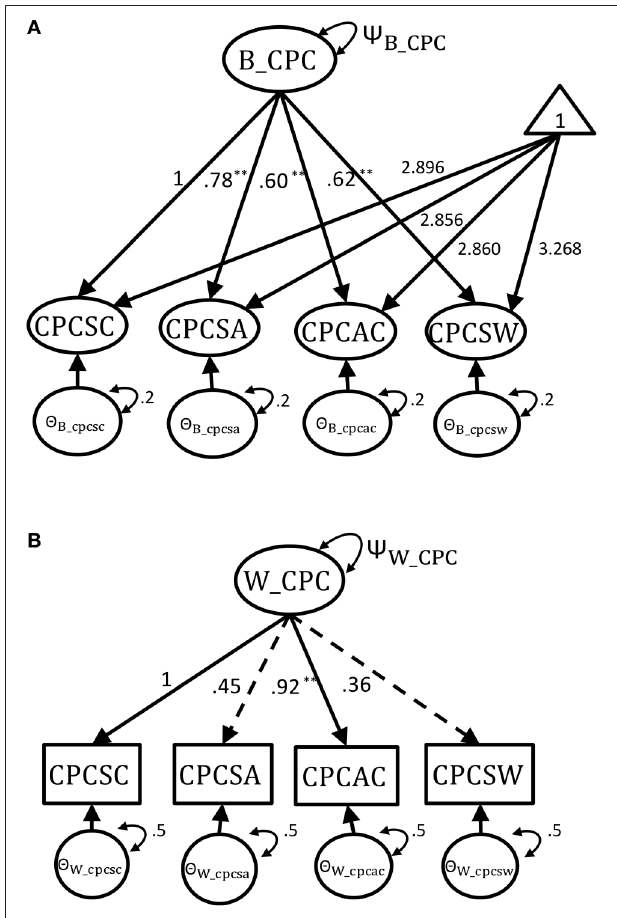
FIGURE 1 | The multilevel CFA model with parameters from empirical Harter dataset. (A) The true between-level model. (B) The true within-level model. ** p <